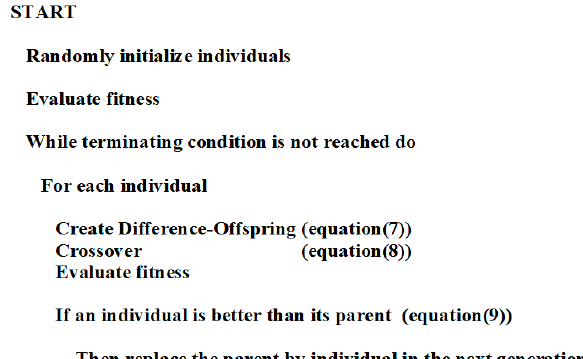
Figure 6. Pseudocode of differential evolution algorithm.